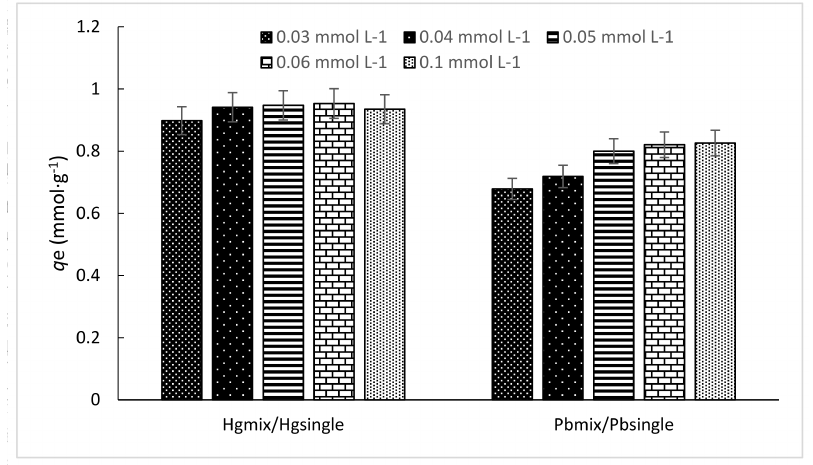
Figure 7. Sorption capacity ratio (scr) changes. ( T : 20 ◦ C; sorbent dosage: 1 g · L − 1 ; agitation speed: 180 rpm; contact time: 48 h, pH o = 4.5, C o = 0.03–0.1 mmol · L − 1